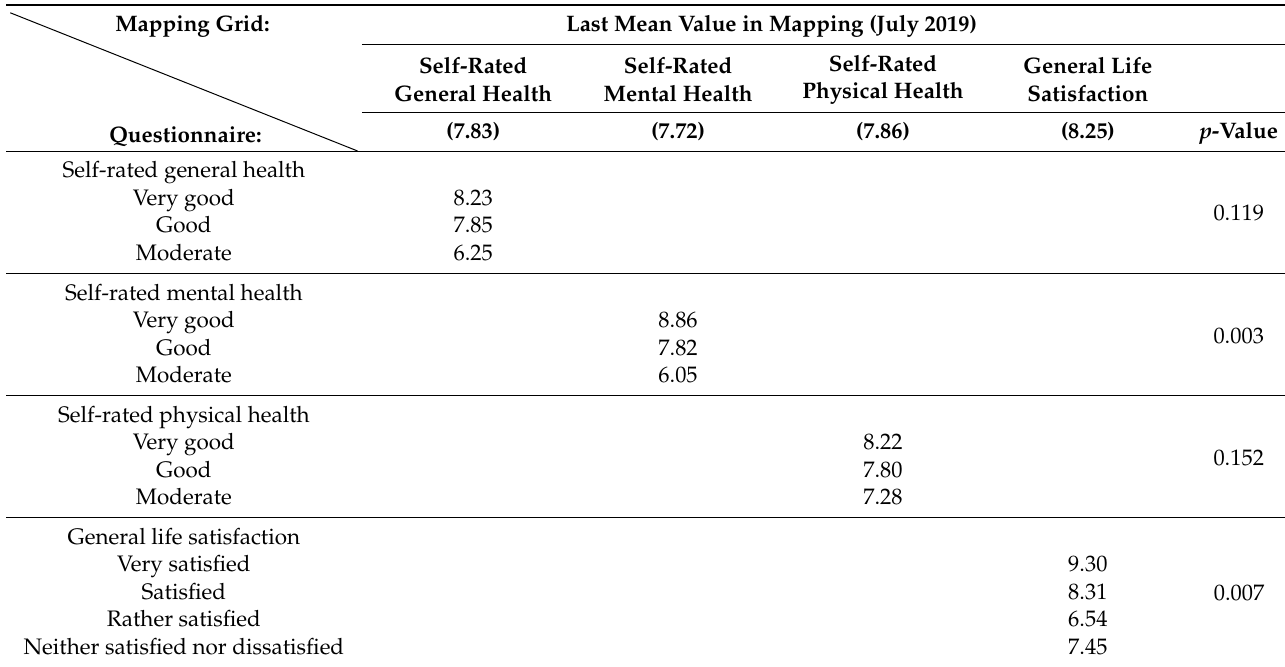
Table 2. Last mean value in mapping regarding health status by responses to the